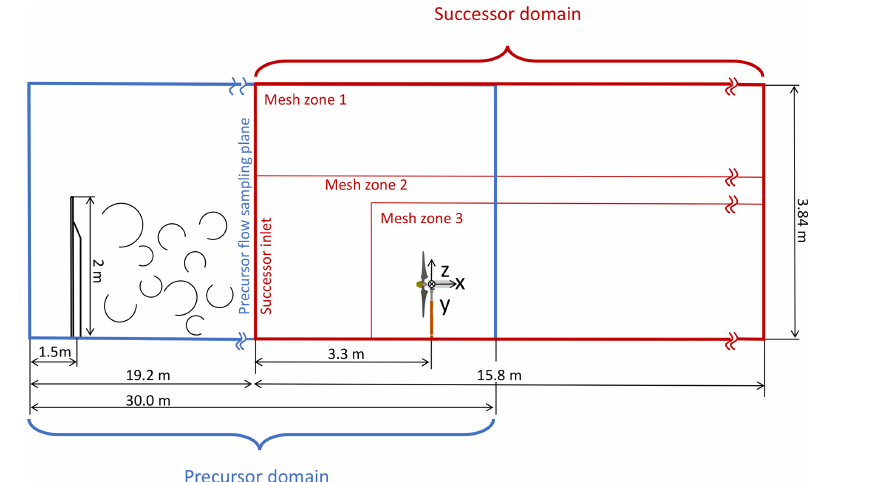
Figure 1. Layout of the partially overlapped precursor and successor computational domains.